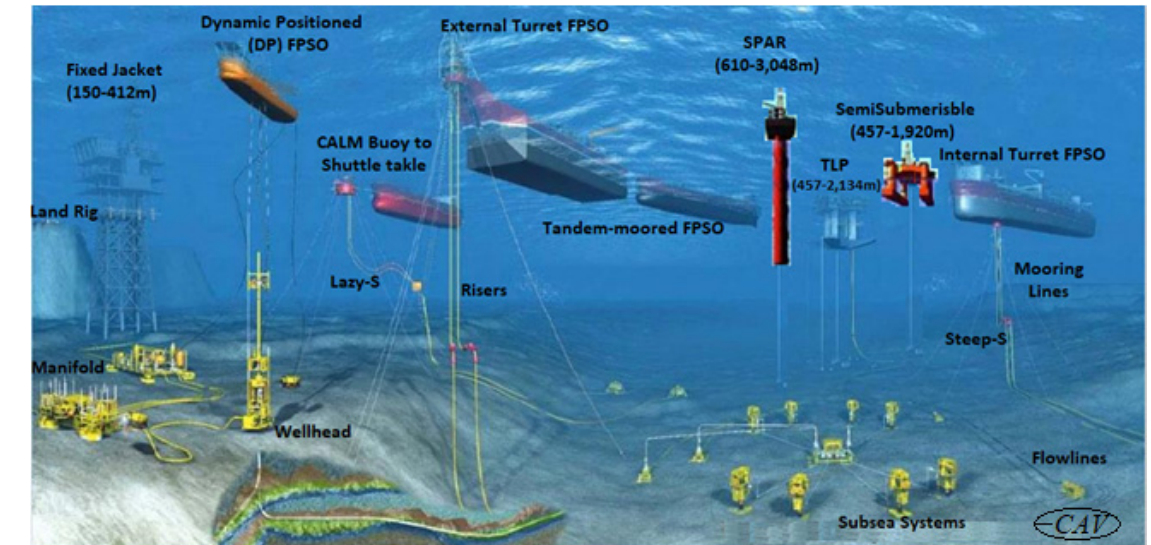
Figure 1. Deep water facilities showing offshore platforms with the configurations for marine risers and mooring lines.